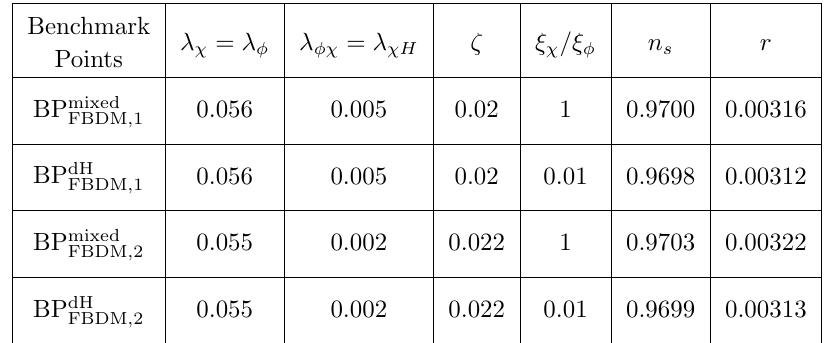
Table 3 . Input parameters for the benchmark points. They correspond to the black points in (cid:12)gures 7 and 8. We chose g X = 0 : 1 ; sin (cid:18) = 10 (cid:0) 5 , " = 10 (cid:0) 4 , m h 0 = 0 : 16 GeV and m (cid:31) = 0 : 1 GeV. The superscript represents the in(cid:13)ation type; for example, BP mixed point where the mixed (dark Higgs) in(cid:13)ation is allowed, etc.